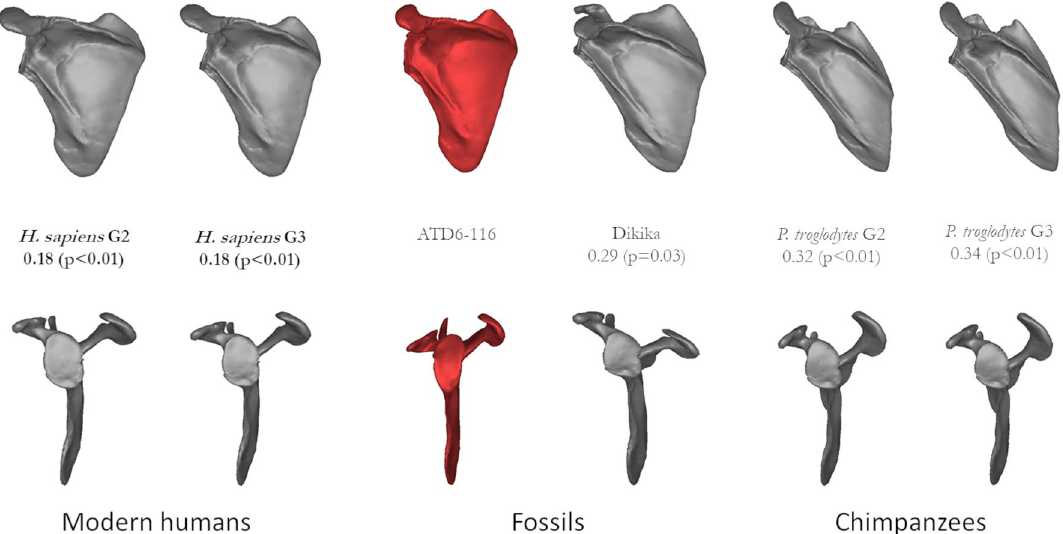
Figure 2. Mean shape comparisons from ATD6-116 (center, red) next to the most similar groups based on size and (probable) developmental stage. The Procrustes distance from ATD6 to each group is shown as well as the result of the permutation test. Note that the distal-most point of the acromion is hypothetically depicted here as it is not fully ossified in individuals of this age stage. The distal-most ossified point was the captured landmark across the comparative sample (see also Table